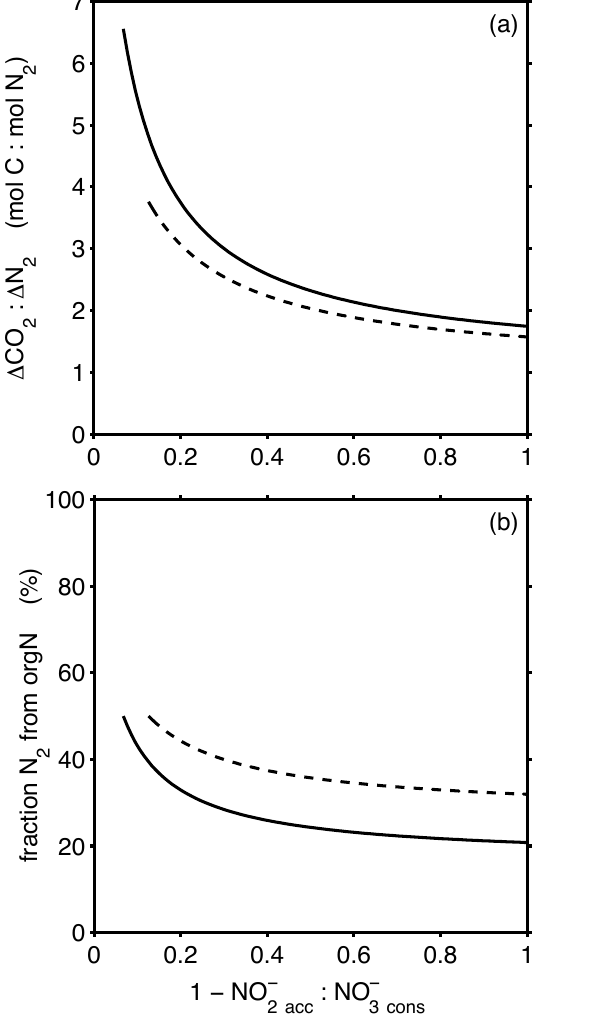
Fig. 2. Same N-conversion scenario as Fig. 1 (DNRN+denitrification+anammox; solid lines for OM com- position of C 106 H 175 O 42 N 16 P; dashed lines for proteins). (a) The net ratio of CO 2 to N 2 release ( 1 CO 2 : 1 N 2 , mol:mol) as a function of N-conversion efficiency. The ratios include a correction for autotrophic CO 2 fixation during anammox. (b) Percent fraction of N 2 -production supported by nitrogen from respired organic matter.